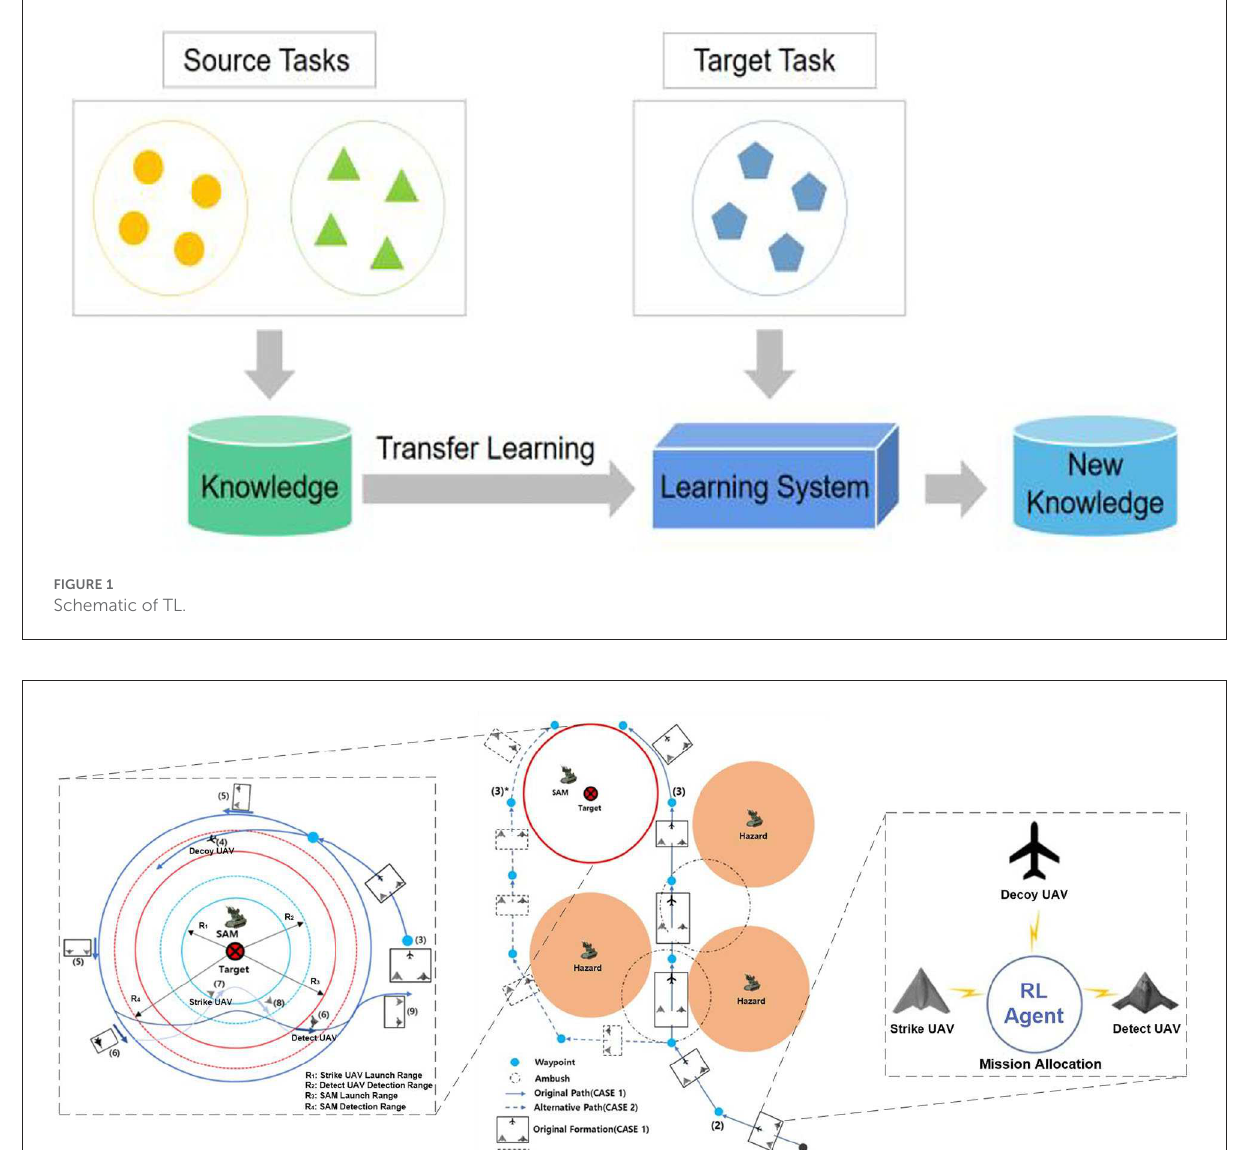
FIGURE2 Multi-UAV cooperative decision-making scenario for the strike mission. The formation can choose the original path (case 1) or an alternative path (case 2) when flying to the SAM airspace.